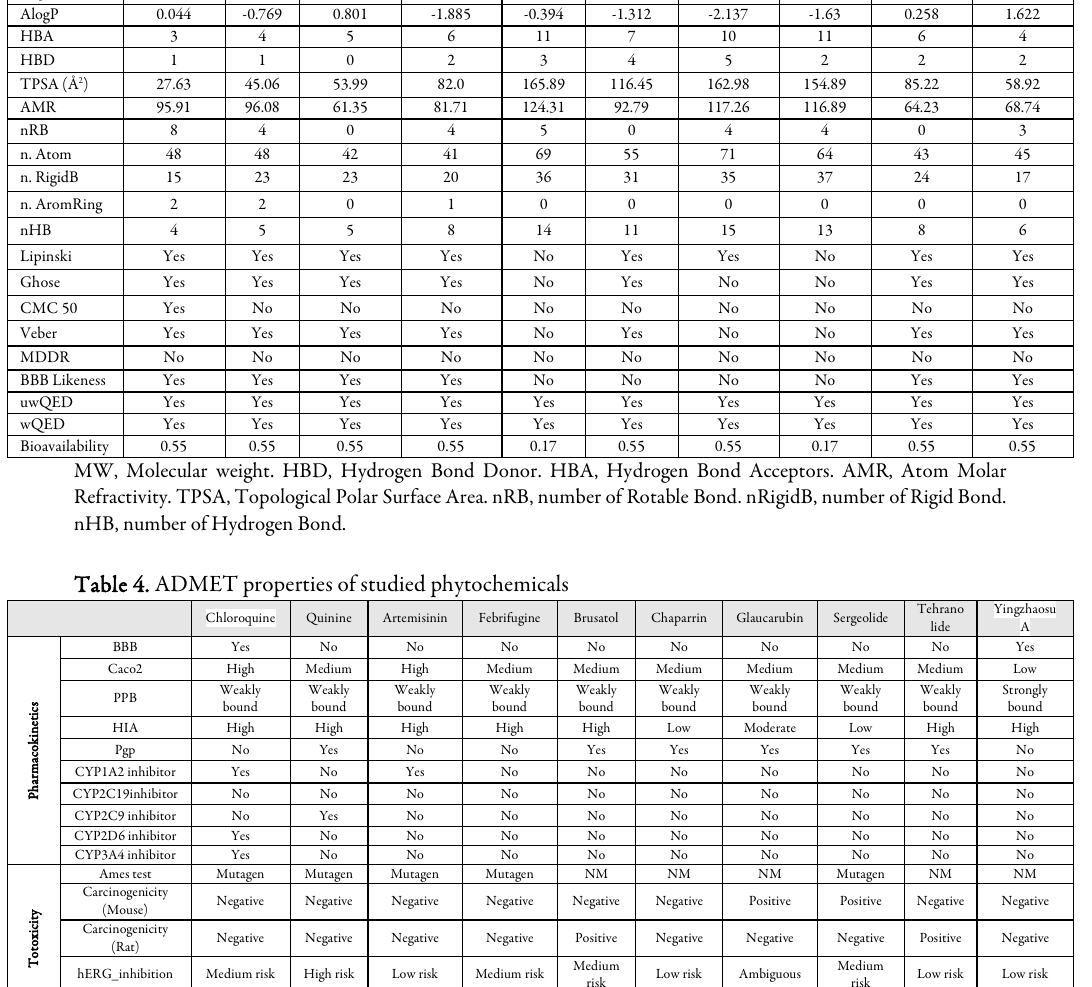
H-HT Positive Negative Synthetic